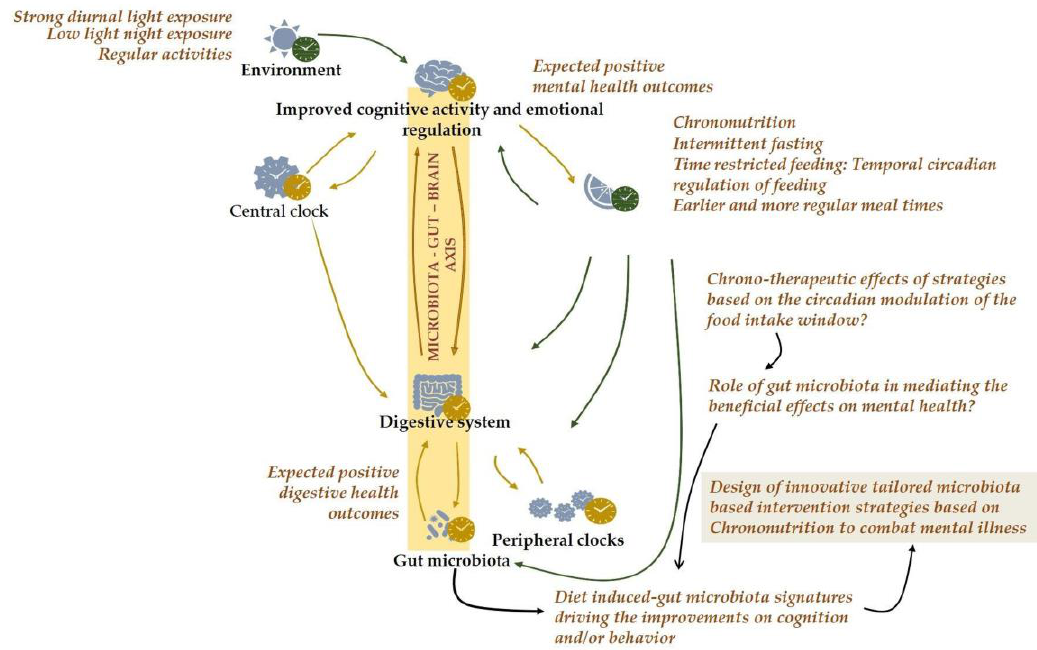
Figure 4. The advised high potential of chrononutrition-based strategies among the approaches for targeting the circadian system in the prevention and care of mental disorders. Irregular and mistimed eating pattern has been pointed out as a disruptive factor for mental health. The discovery of Chrononutrition-based strategies induced-gut microbiota signatures driving improvements on cognition and/or behavior could help to the design of innovative tailored microbiota-based intervention strategies for targeting mental illness. These microbiota-based strategies could also be further explored in combination with other lifestyle interventions, which may have potentially significant implications for personalized nutrition/medicine in terms of reducing the prevalence and burden of mental health disorders.